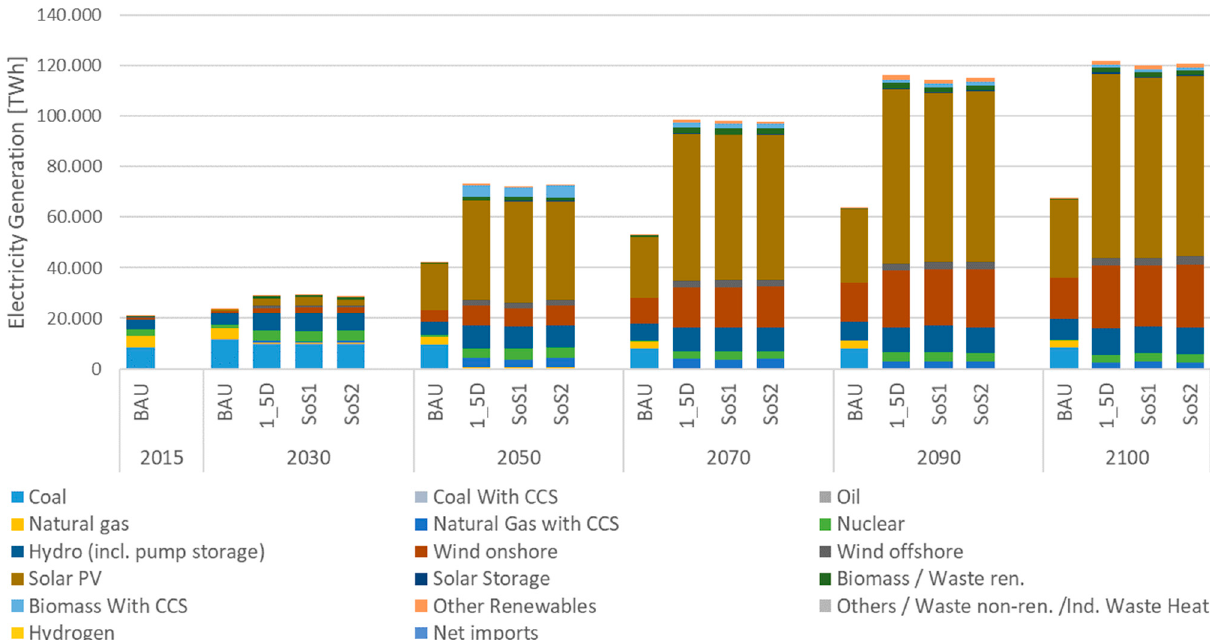
Figure 5. Global electricity generation.